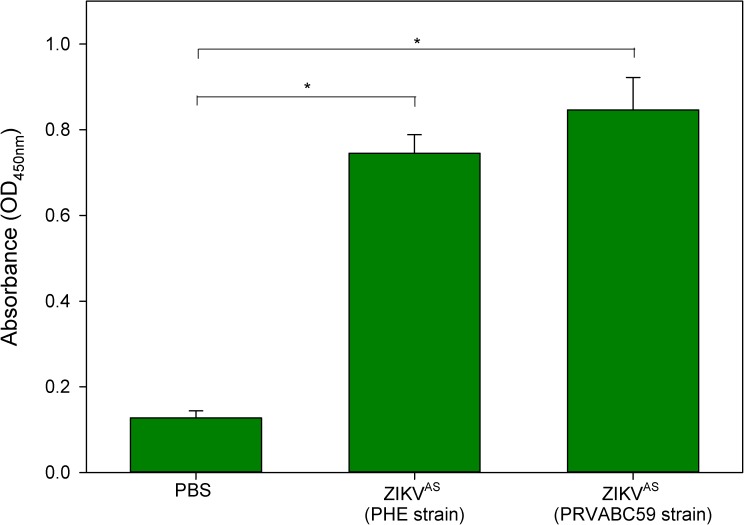
Seroreactivity data of A129 mice challenged with different strains of ZIKVAS.Sera collected 14 days post-challenge were assessed for antibody responses to ZIKV. * indicates statistical significance (P<0.05, Mann-Whitney test).